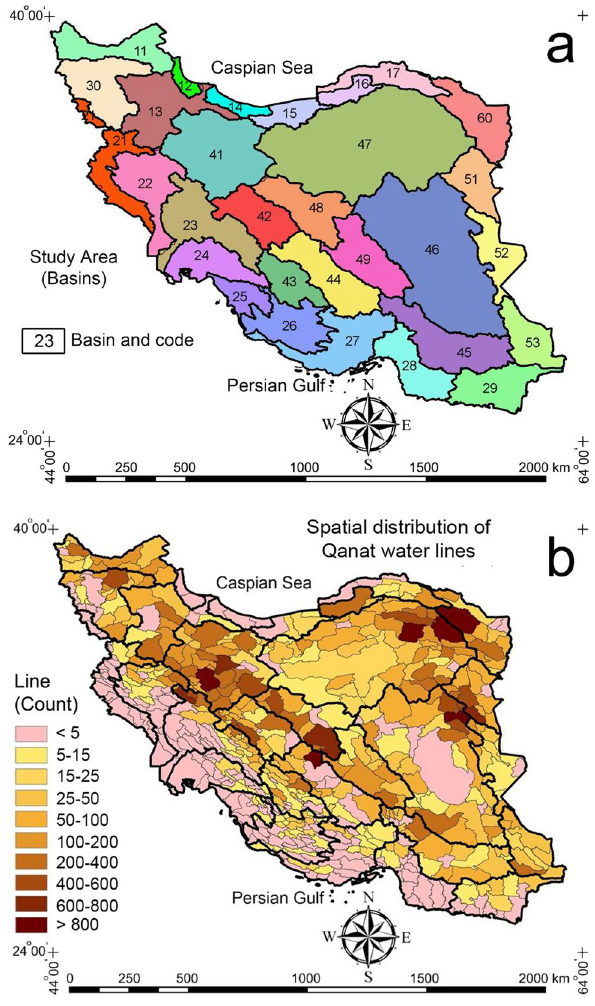
Fig. 1 Geographical position of the study areas including a . 30 major hydrological basins of Iran and b . spatial distribution of Qanat water